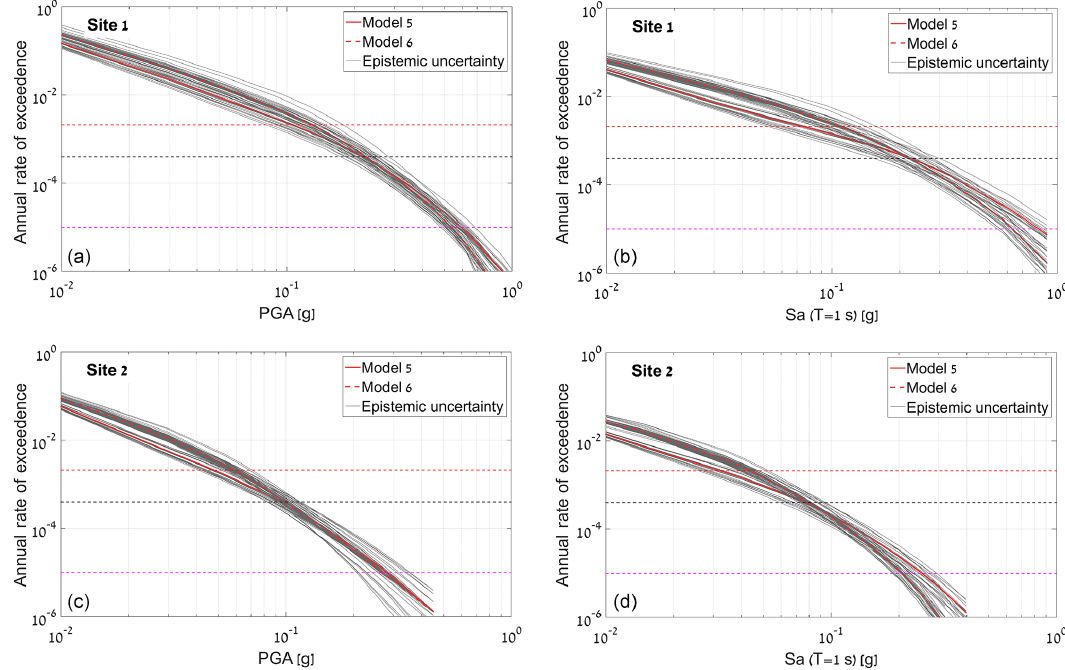
Figure 10. Hazard curves for models 5 and 6, showing the full range of parametric uncertainty, for (a) site 1 at T = 0.01s, (b) site 1 at T = 1.0s, (c) site 2 at T = 0.01s, and (d) site 2 at T = 1.0s. The weighted averages are represented by the red curves.